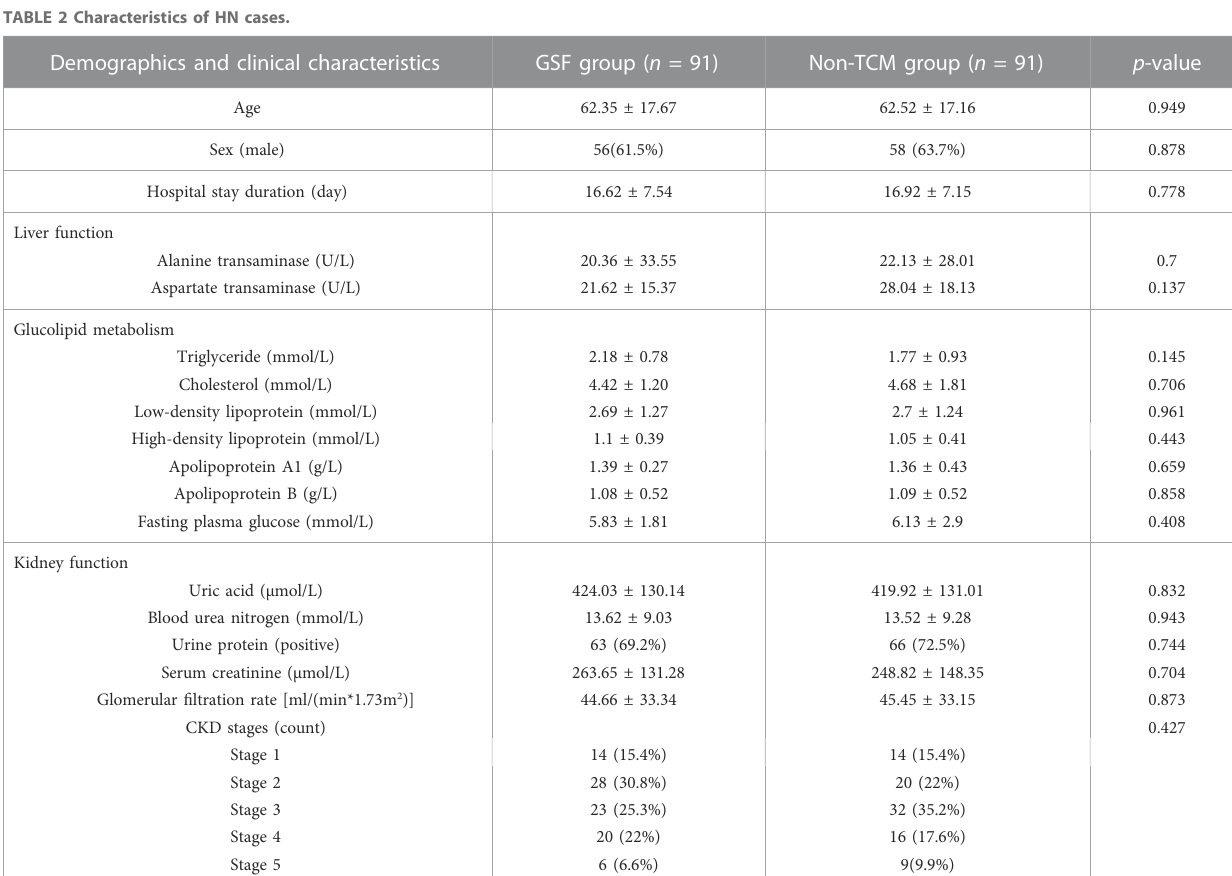
TABLE 2 Characteristics of HN